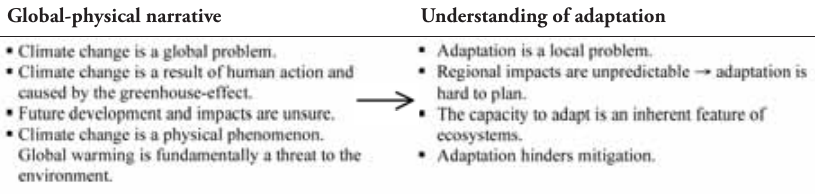
Table 2: Elements of a global-physical narra-